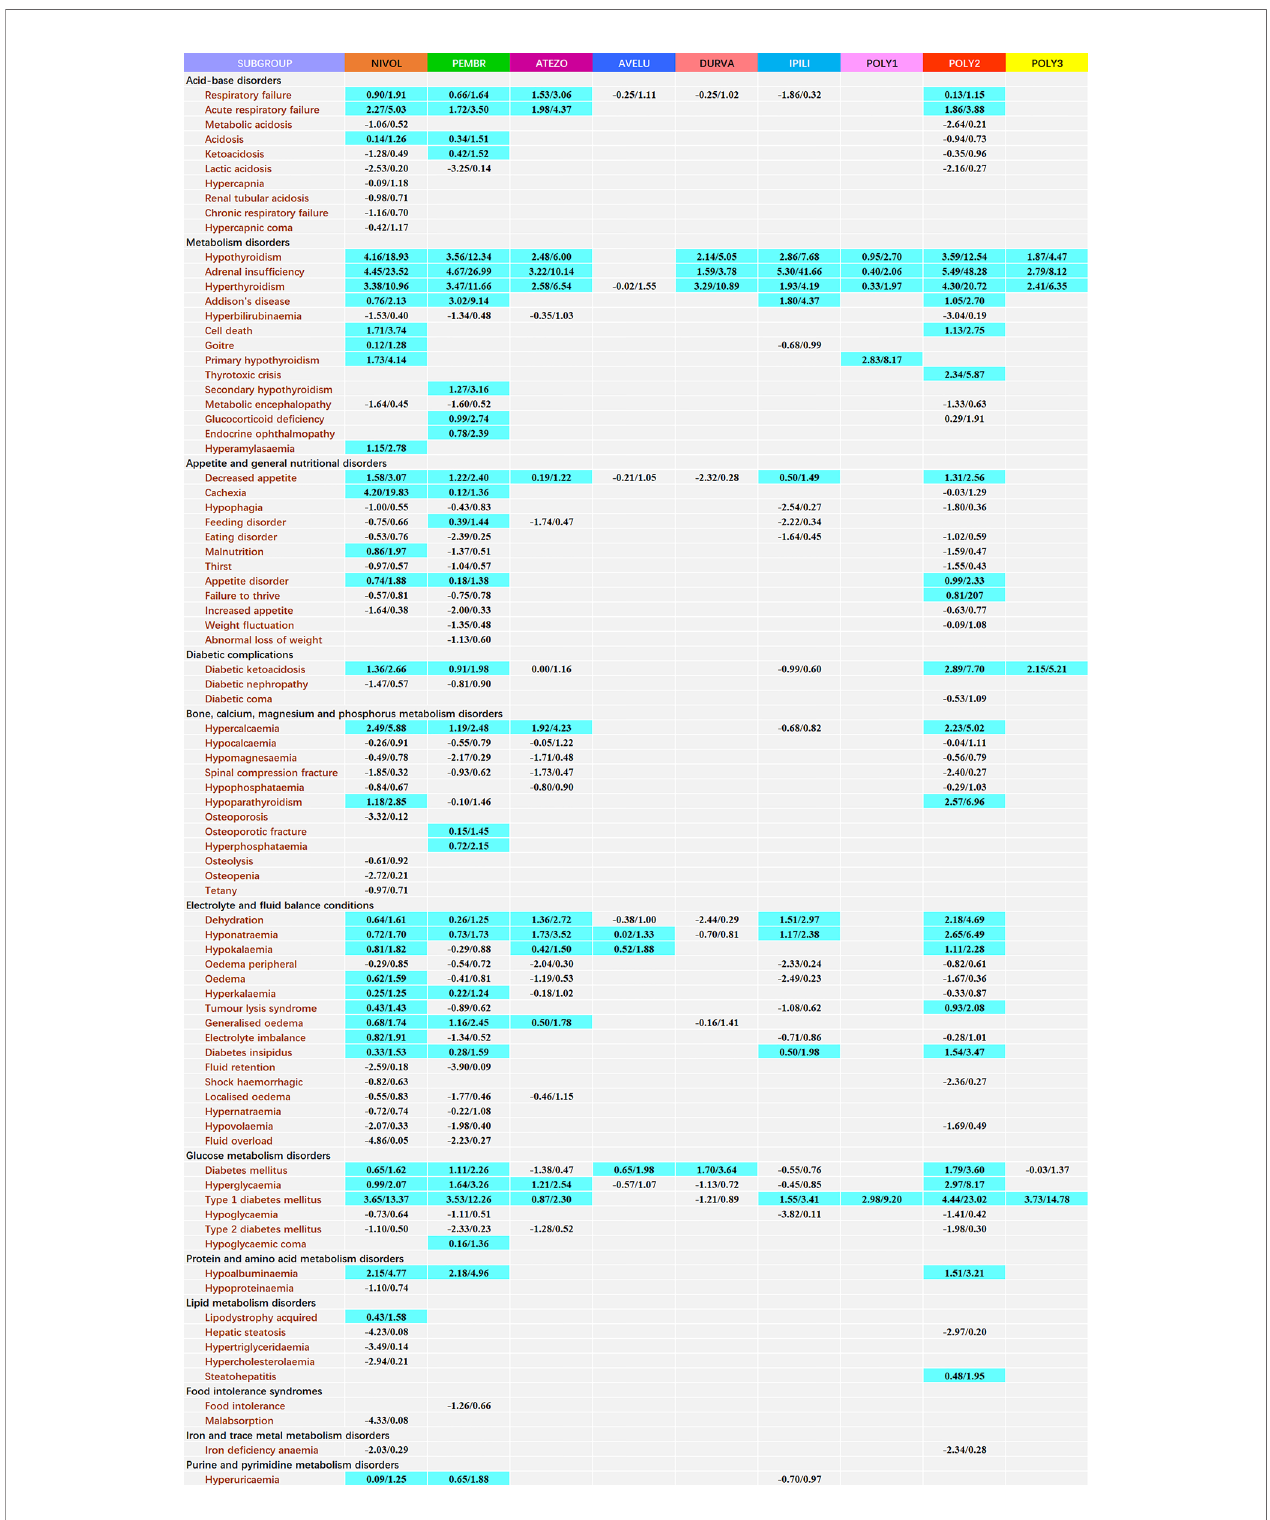
FIGURE 1 | Safety pro fi le of metabolism and nutrition diseases according to different ICI regimens*. *Each cell of the safety pro fi le contains the values of IC 025 and ROR 025 (lower end of the 95% con fi dence interval of IC and ROR, respectively); NIVOL, nivolumab; PEMBR, pembrolizumab; ATEZO, atezolizumab; AVELU, avelumab; DURVA, durvalumab; IPILI, ipilimumab; POLY1, nivolumab+ pembrolizumab+ ipilimumab; POLY2, nivolumab+ ipilimumab; POLY3, pembrolizumab+ ipilimumab. To obtain robust results and reduce the false positive signals, signal values were only calculated for complications with at least 3 records. A signal was de fi ned as both IC 025 >0 and ROR 025 >1 and highlighted in blue.